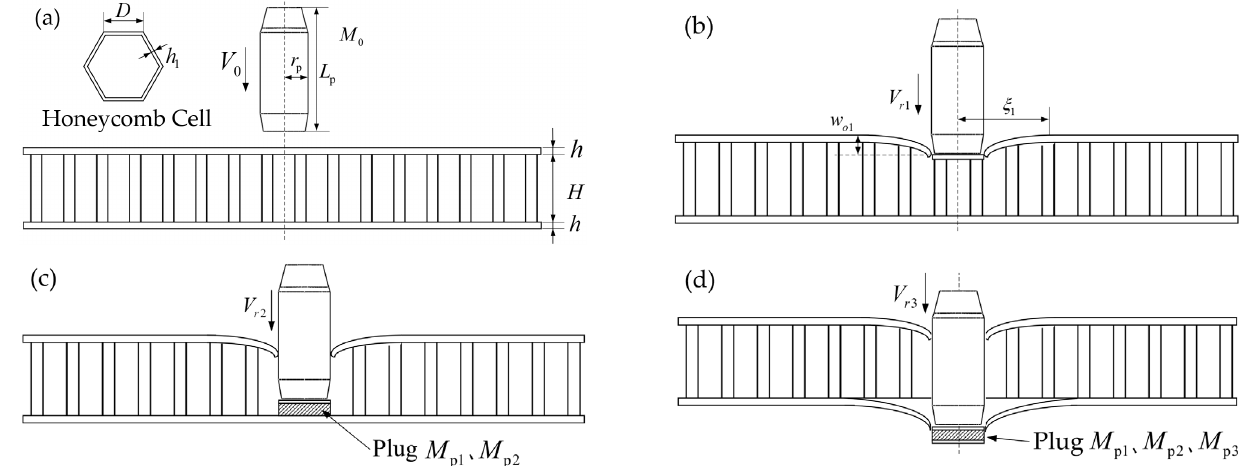
Figure 7. Theoretical model of the kinetic projectile hitting honeycomb sandwich panel: ( a ) schematic diagram; ( b ) first stage; ( c ) second stage; ( d ) third stage.